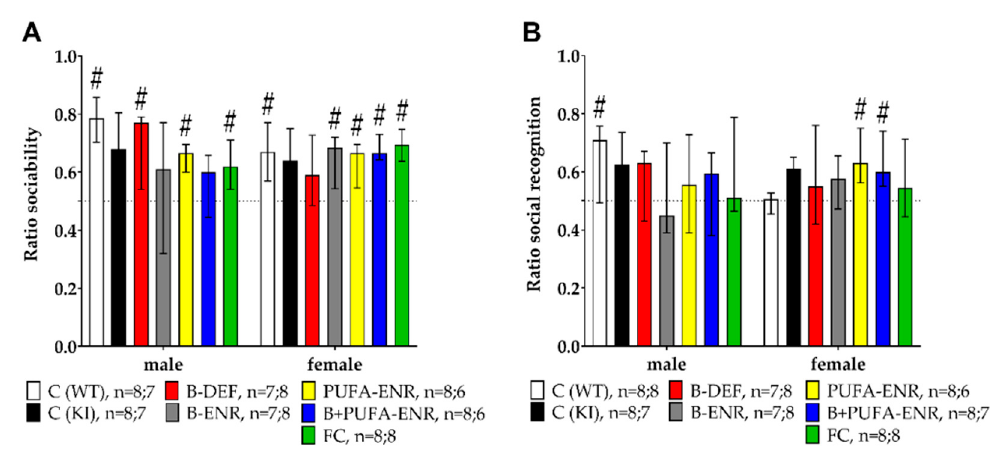
Figure 7. Social interaction test (25 min) in 19–20 weeks old C57BL/6J and App NL-G-F mice; 14–15 weeks on experimental diet; data presented as median ± IQR; outliers beyond threefold IQR removed; p < 0.05 (Mann-Whitney-U-test) considered statistically significant (*); ( # ) ratio di ff erent from 0.5 (one-sample Wilcoxon signed rank test). ( A ) Sociability expressed as the ratio between the contact time with the stimulus mice and the sum of the contact times with the stimulus mice and the empty cage. ( B ) Social recognition expressed as the ratio between the contact time with novel stimulus mice and the familiar